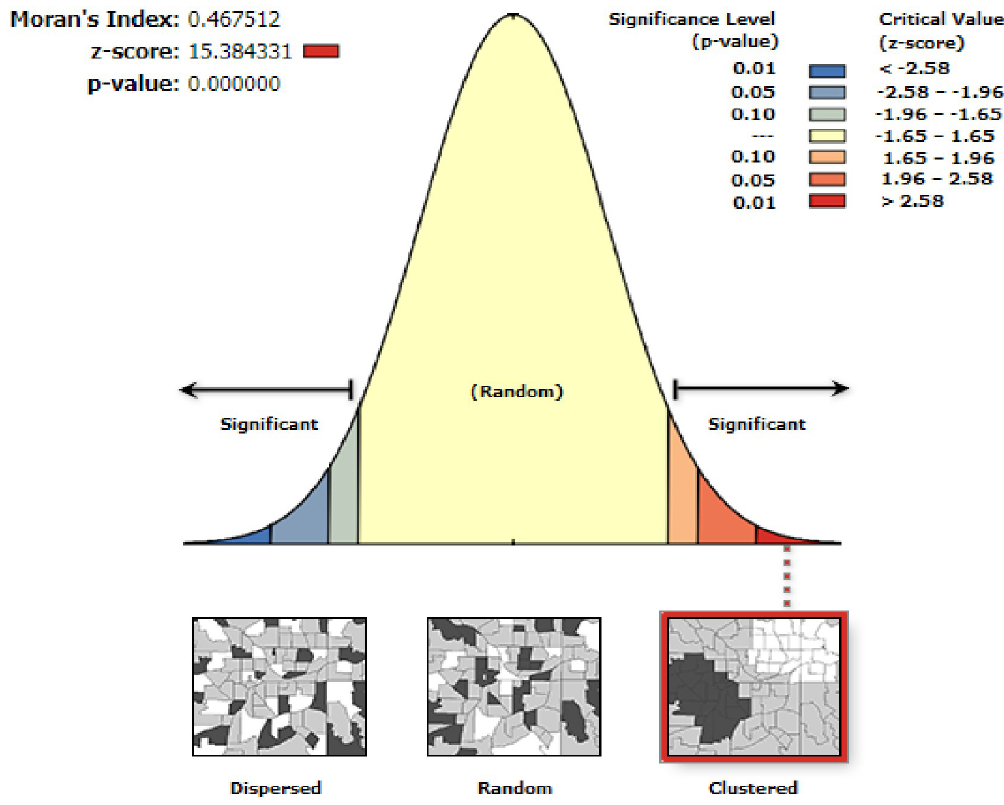
Fig 1. Global spatial autocorrelation of incomplete utilization of maternal continuum of care in Ethiopia, produced using Arc GIS version 10.7.